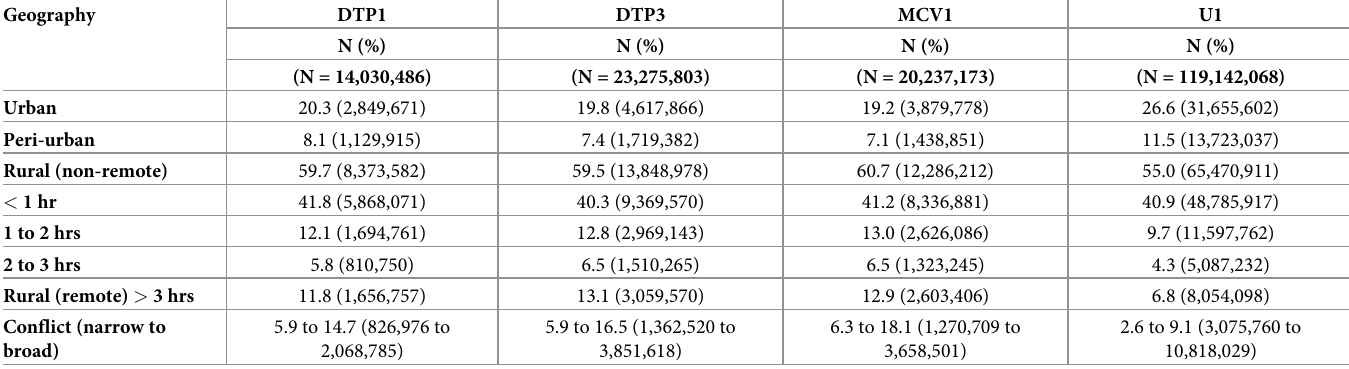
Table 1. Global distribution of unvaccinated children under 1 year of age (percentage and number) in 2019 broken down by geographical setting, vaccine dose, and conflict for all countries in the analysis (Note: Conflict can overlap with other settings in the table).